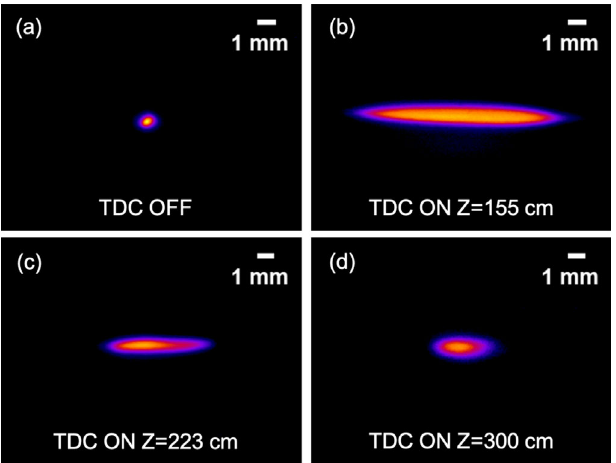
FIG. 5. Phase dependence of the charge and beam energy of the ECC-rf gun.